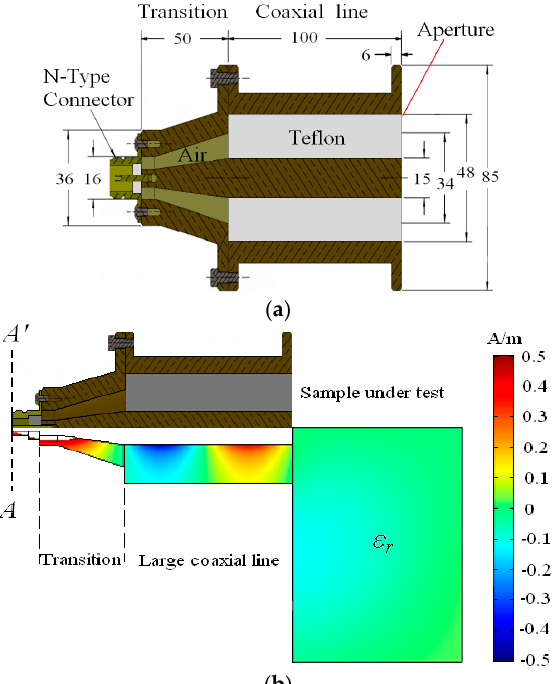
Figure 3. ( a ) Cross-sectional view and dimensions (in millimeter) of the probe. ( b ) Half axial symmetry magnetic fields simulation for the probe using COMSOL Multiphysics with ε r = 1 at 2 GHz.